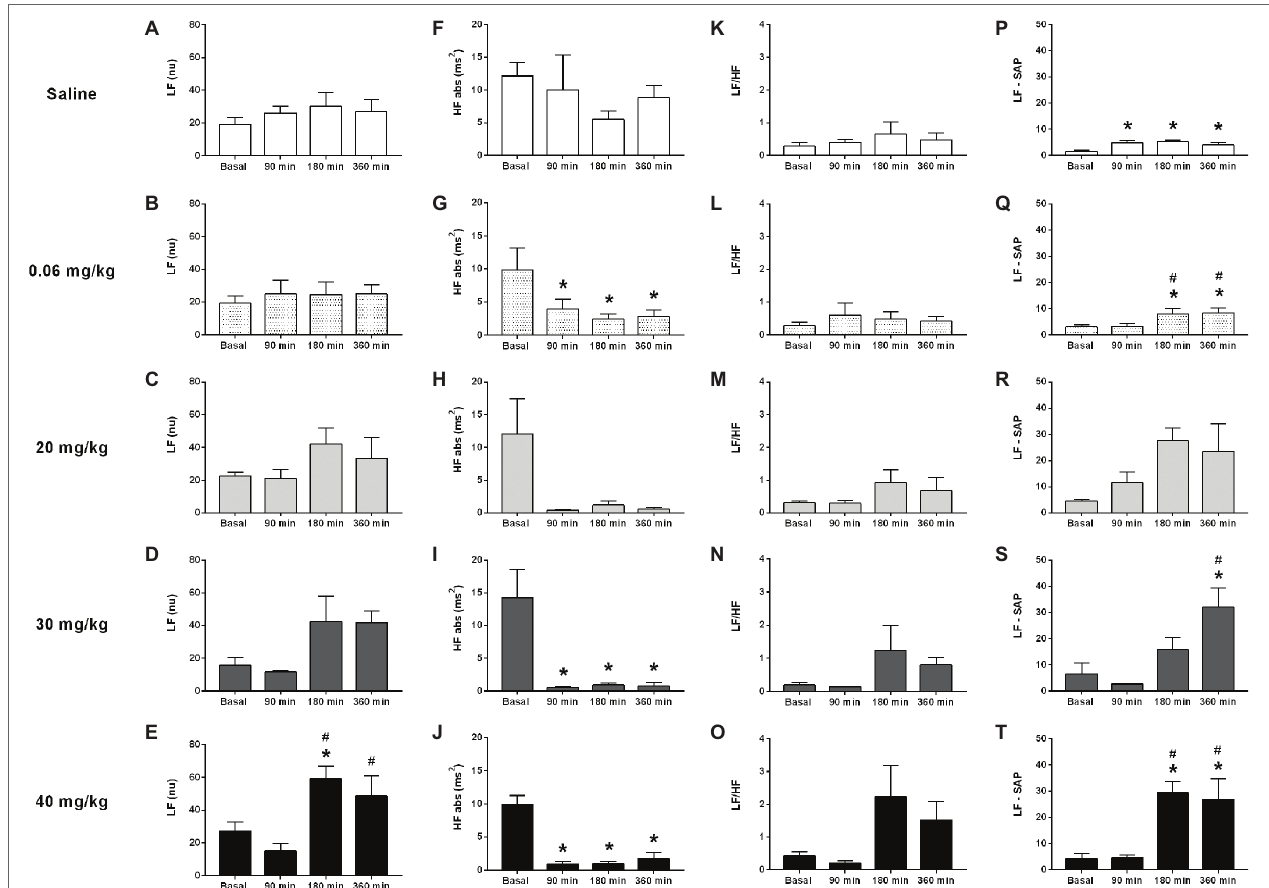
FIGURE 2 | Effects of different doses of lipopolysaccharide in the heart rate variability from unanesthetized rats. The heart rate variability parameters are the following: LF band (LF), HF band (HF), LF/HF ratio, and LF from the systolic arterial pressure (LF-SAP). Saline: panels (A,F,K,P) ; 0.06 mg/kg of LPS: panels (B,G,L,Q) ; 20 mg/kg of LPS: panels (C,H,M,R) ; 30 mg/kg of LPS: panels (D,I,N,S) ; 40 mg/kg of LPS: panels (E,J,O,T) . Data are expressed as mean ± standard error of the mean. * p < 0.05 vs. baseline counterpart; # p < 0.05 vs. 90 min counterpart. LF, low frequency; HF, high